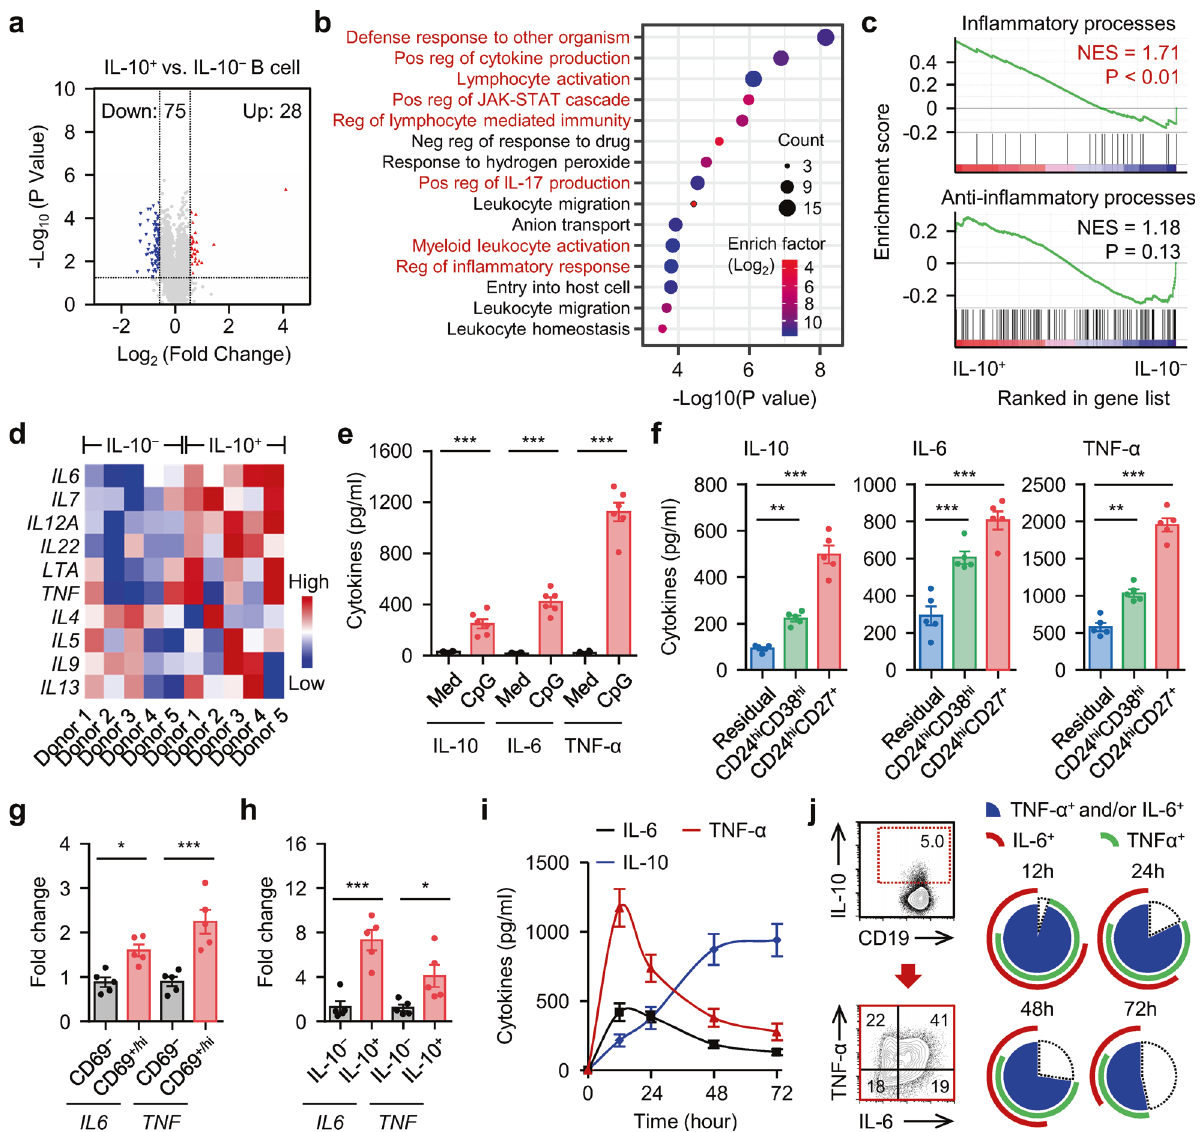
rate correction ( n = 5). b Functional annotation of 103 differential gene expression listed in a were analyzed by DAVID tool. The top 15 enrichment GO terms are listed. c GSEA of in fl ammatory processes (WP530) and anti-in fl ammatory processes (GO: 0050728) in IL-10 + B cells versus IL-10 − B cells. NES, normalized enrichment score. d Heat map displaying in fl ammatory and anti-in fl ammatory cytokine expression in IL- 10 + B cells versus IL-10 − B cells ( n = 5). e , f Puri fi ed total B cells ( e ), CD24 hi CD38 hi , CD24 hi CD27 + , and residual B cells ( f ) from HD were cultured in medium or were treated with CPG-DNA for 12 h. IL-10, IL-6, and TNF- α production were detected by ELISA ( n = 6). g , h Expression of IL6 and TNF in CD69 − and CD69 + /hi B cells ( g ), or in IL-10 − and IL-10 + B cells ( h ) isolated from untreated SLE patients were detected by real-time PCR ( n = 5). i , j Total B cells puri fi ed from HD were cultured in medium or treated with CPG-DNA. Dynamics of IL-10, IL-6, and TNF- α production was measured over the indicated times by ELISA ( i ). Frequencies of TNF- α + and/or IL-6 + and TNF- α − IL-6 − B cells relative to total B-cell were examined by FACS ( j ) ( n = 6 for i ; n = 5 for j ). Data were acquired from more than four independent experiments and shown as means ± SEM. Signi fi cance was determined with Student ’ s t- test ( e , g , h ) or one-way ANOVA test ( f ). * p < 0.05, ** p < 0.01, *** p <